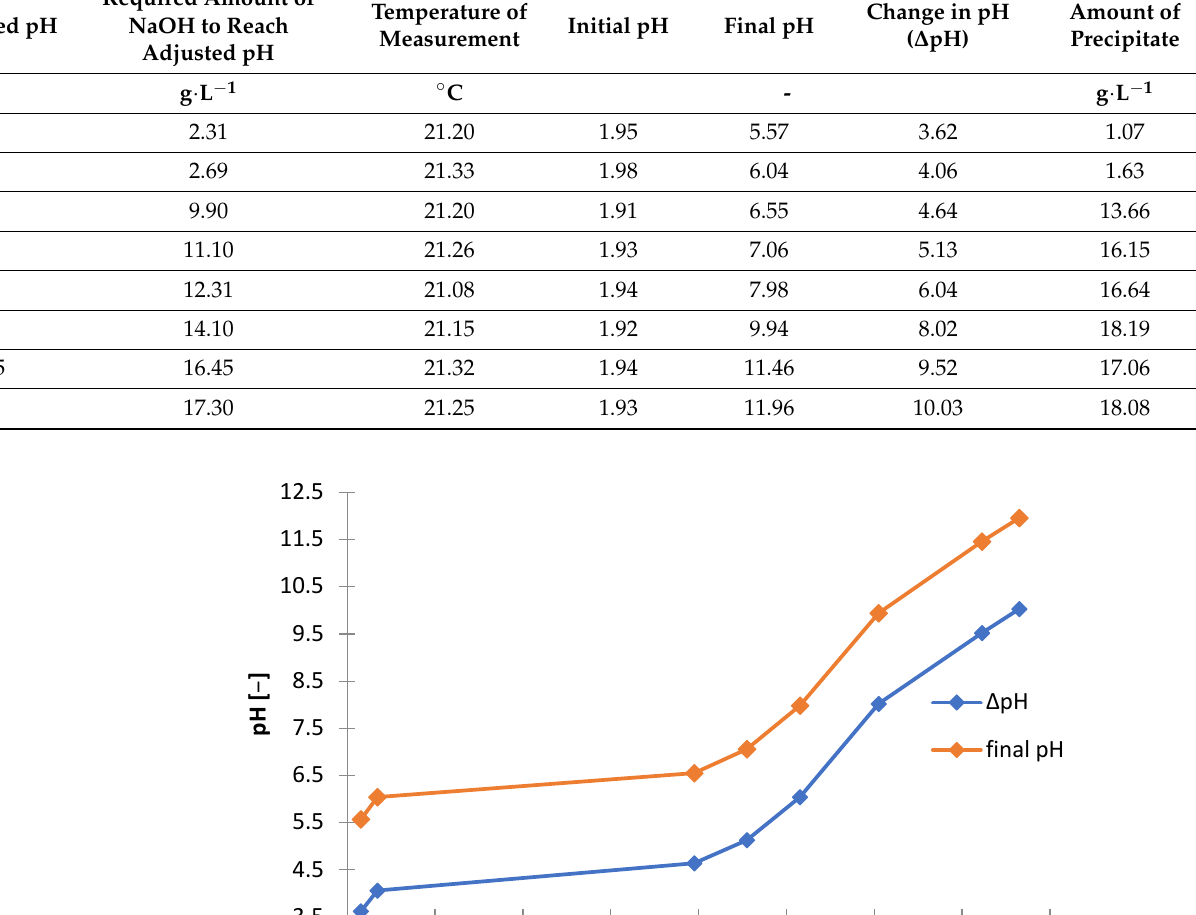
Table 5. Conditions of pH and amount of NaOH during precipitation of zinc and manganese from solution after selective leaching.